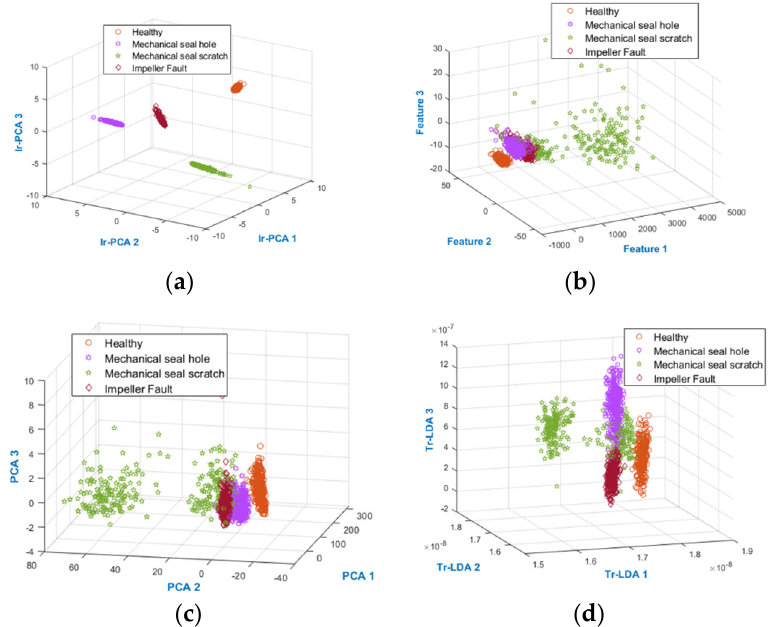
Figure 9. ( a ) Proposed, ( b ) WPT − PCA − MSVM, ( c ) PCA − KNN, and ( d ) Tr − LDA feature